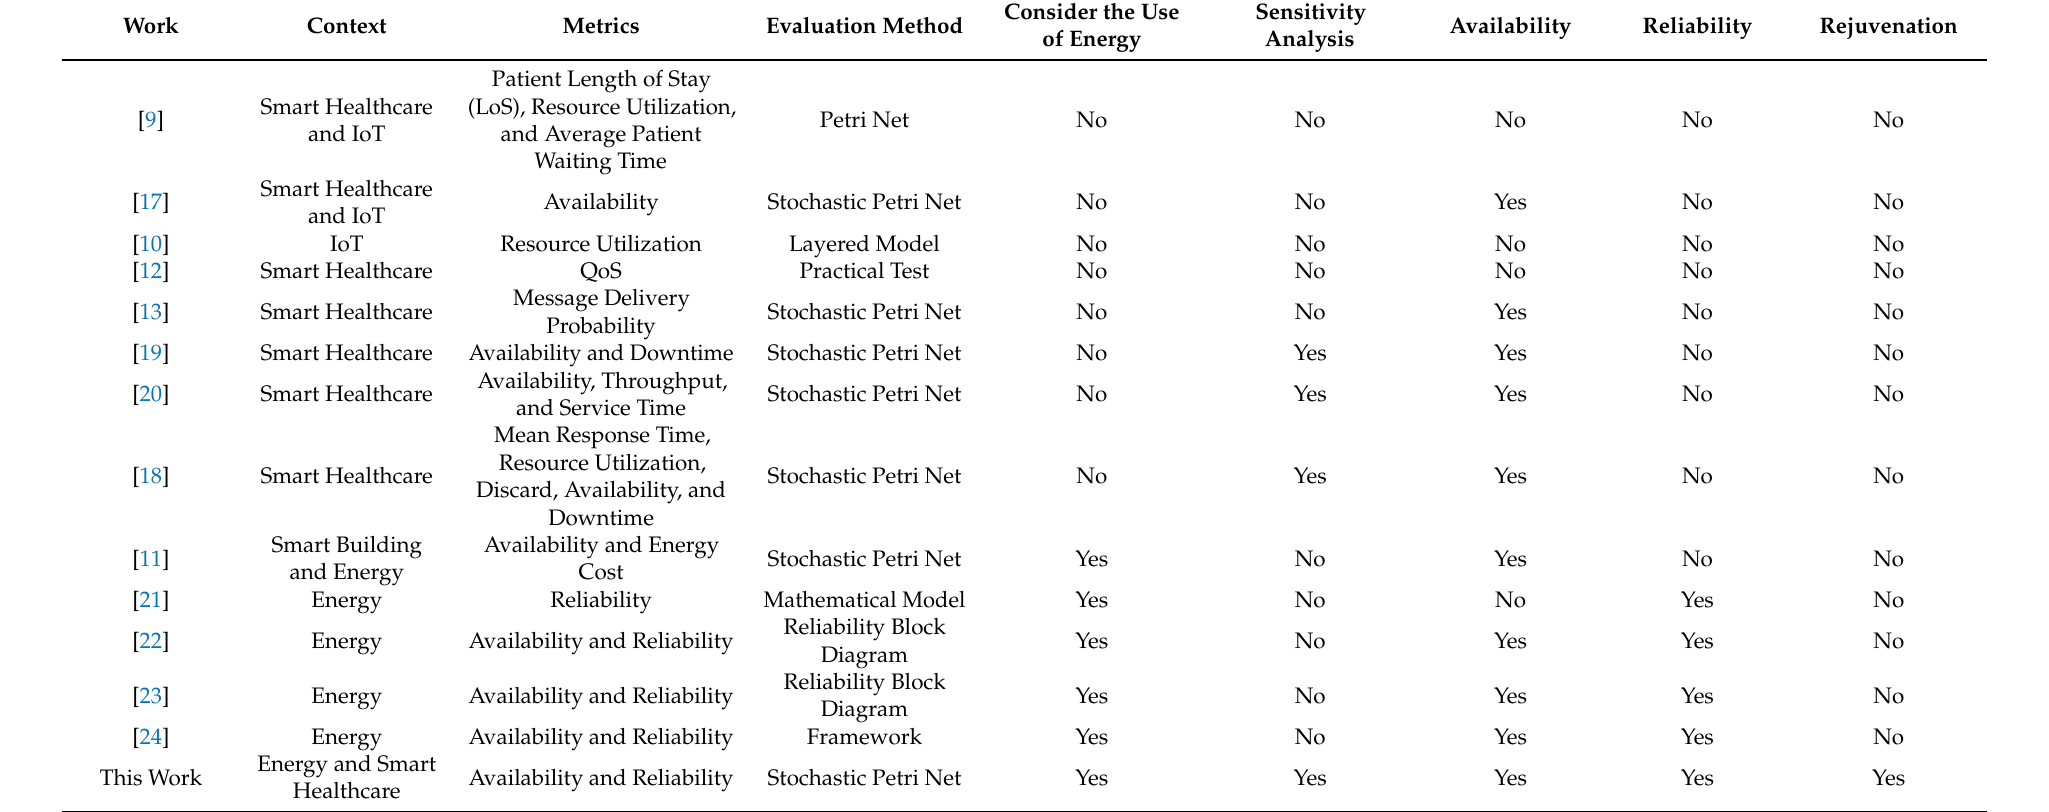
Table 1. Related